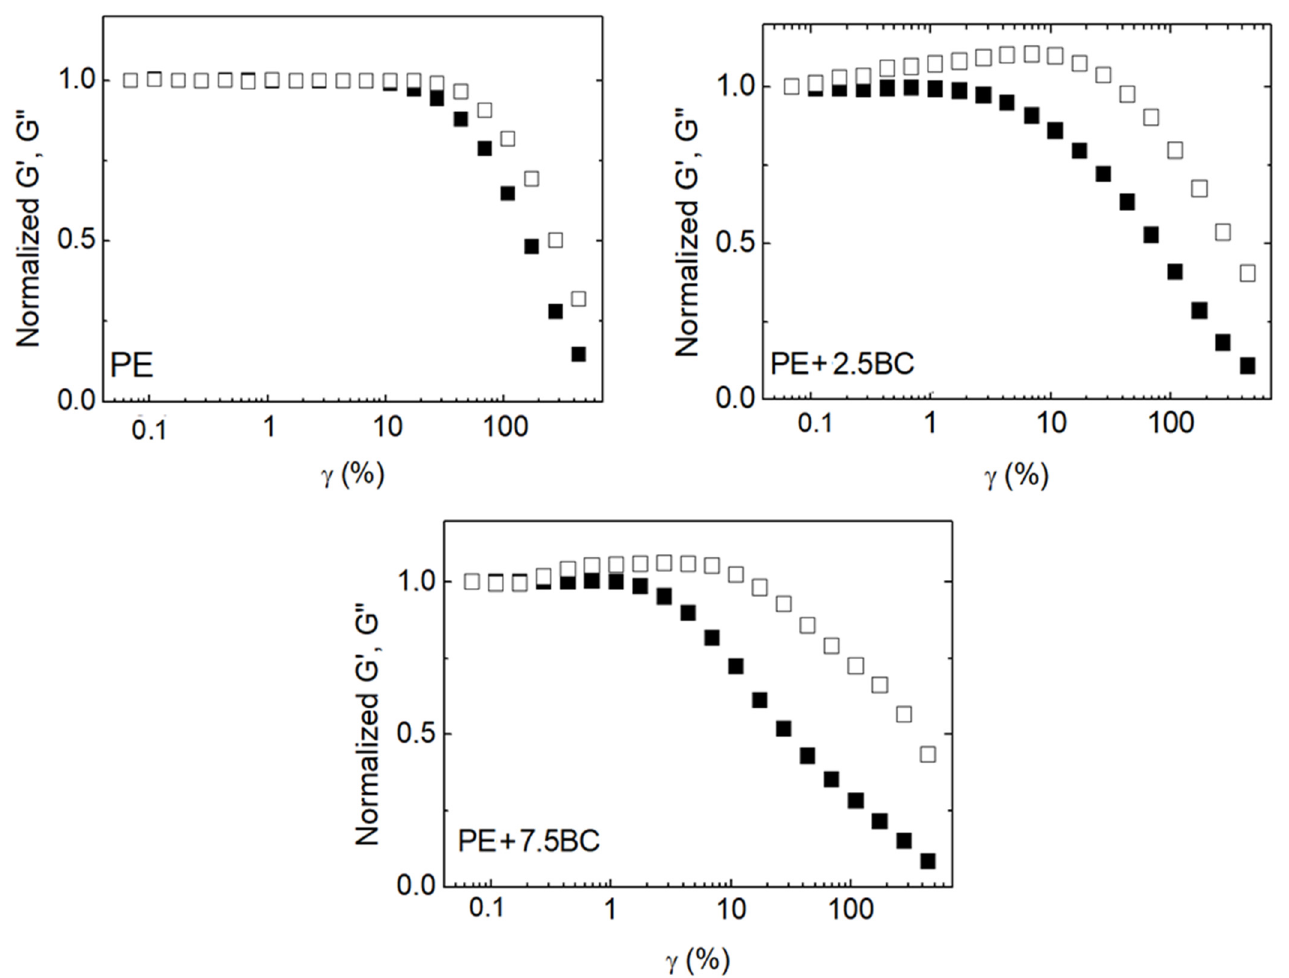
Figure 6. Normalized dynamic moduli (full symbols for G’ and empty symbols for G”) for neat PE and composites with 2.5 and 7.5 wt.% of BC [76]. Reprinted under CC BY 4.0 license.